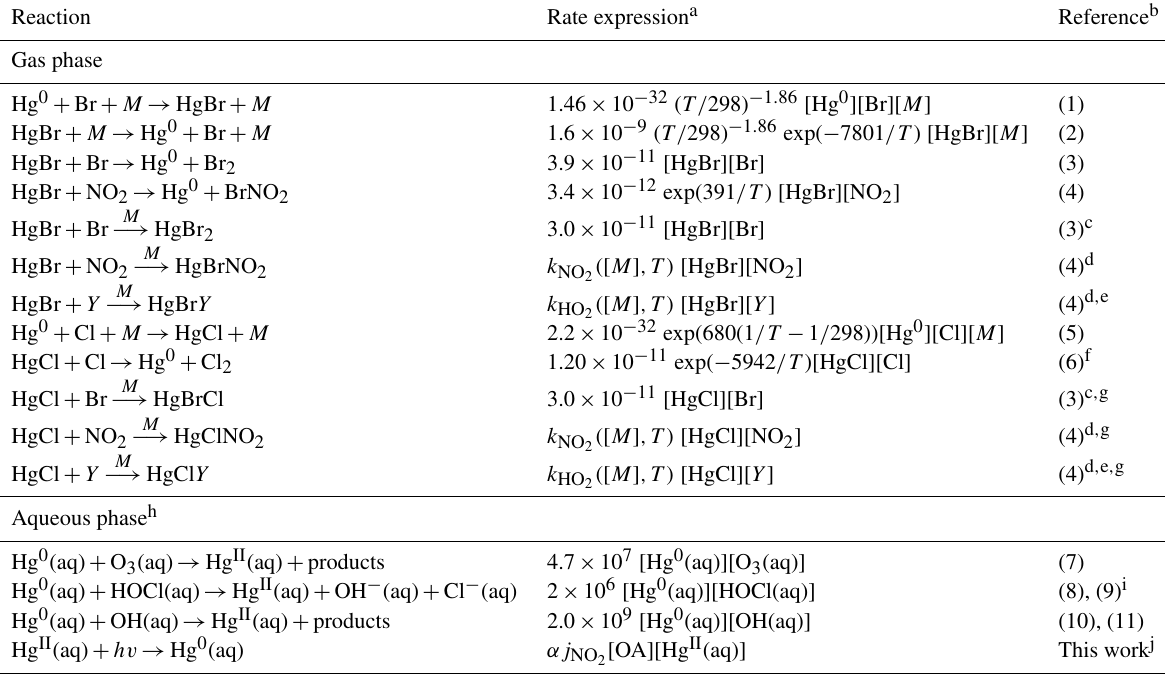
Table 1. Chemical mechanism for atmospheric mercury. Reaction Rate expression